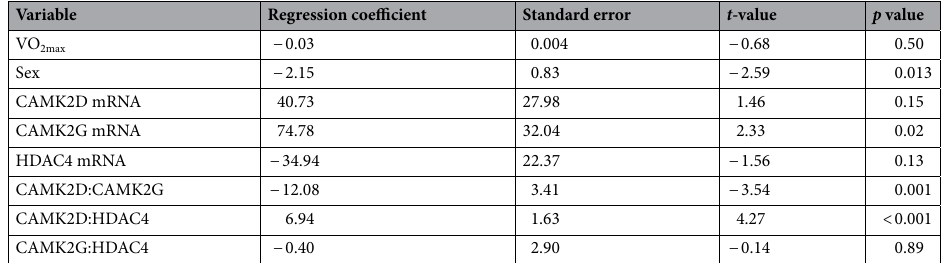
Table 2. Result of the mRNA-based multivariate regression model for S i training response among the subset of White HERITAGE participants for which global gene expression data before and after the exercise program are available (n = 47). Importantly, the response variable (i.e. ∆S i ) spanned a broad range (− 79 to + 120%) among the participants included in the current analysis. Sex and VO 2 max adjusted for body size were included as covariates in the model. Notably, the abundance of these transcripts was not responsive to the training intervention, but rather higher basal expression levels were associated with greater gains in S i .